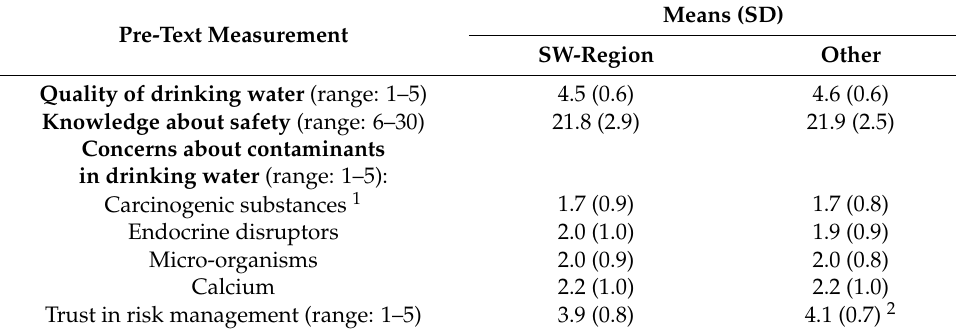
Table 3. Pre-text